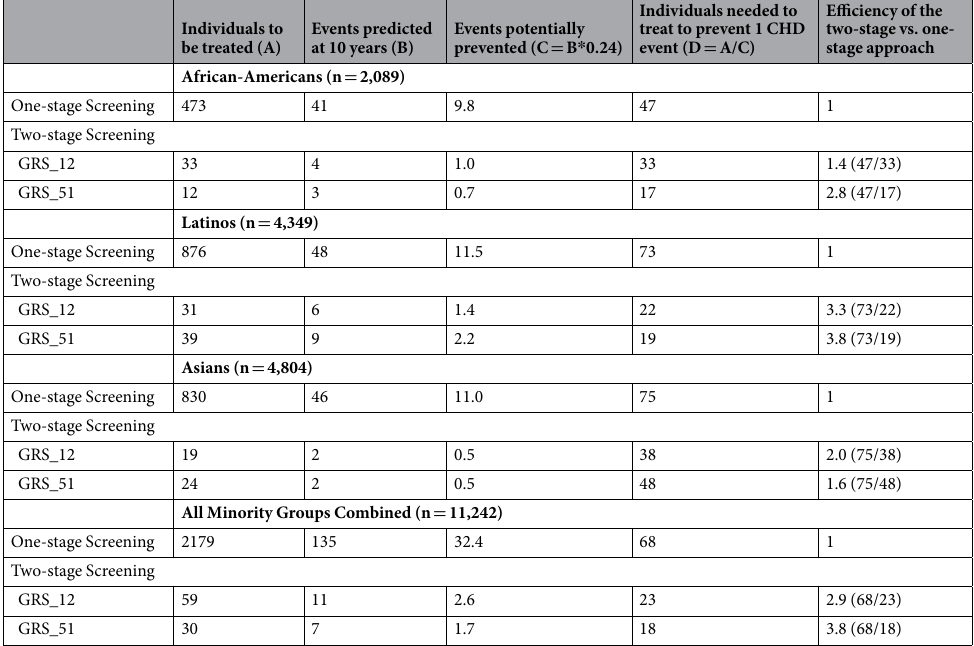
Efficiency of the two-stage vs. one-